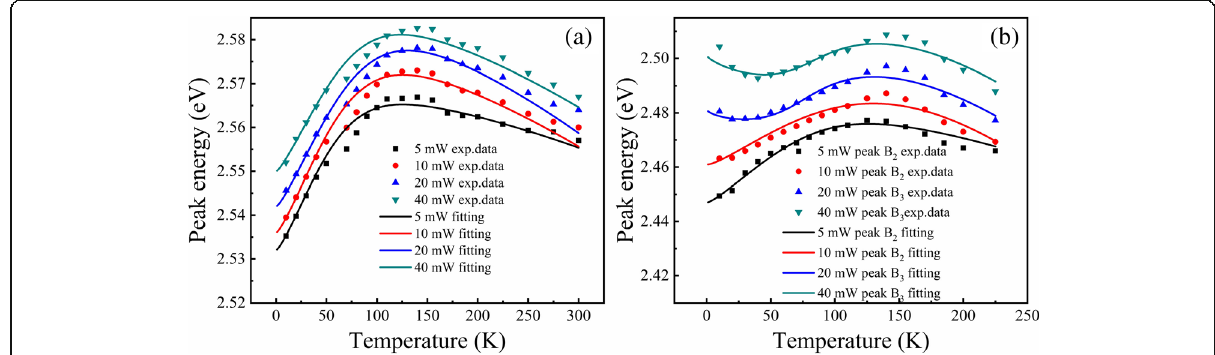
Fig. 5 PL emission peak energy as a function of temperature for samples A ( a ) and B ( b ) under different excitation powers. The solid lines are theoretical fitting curves using LSE model. The dots are the experiment data